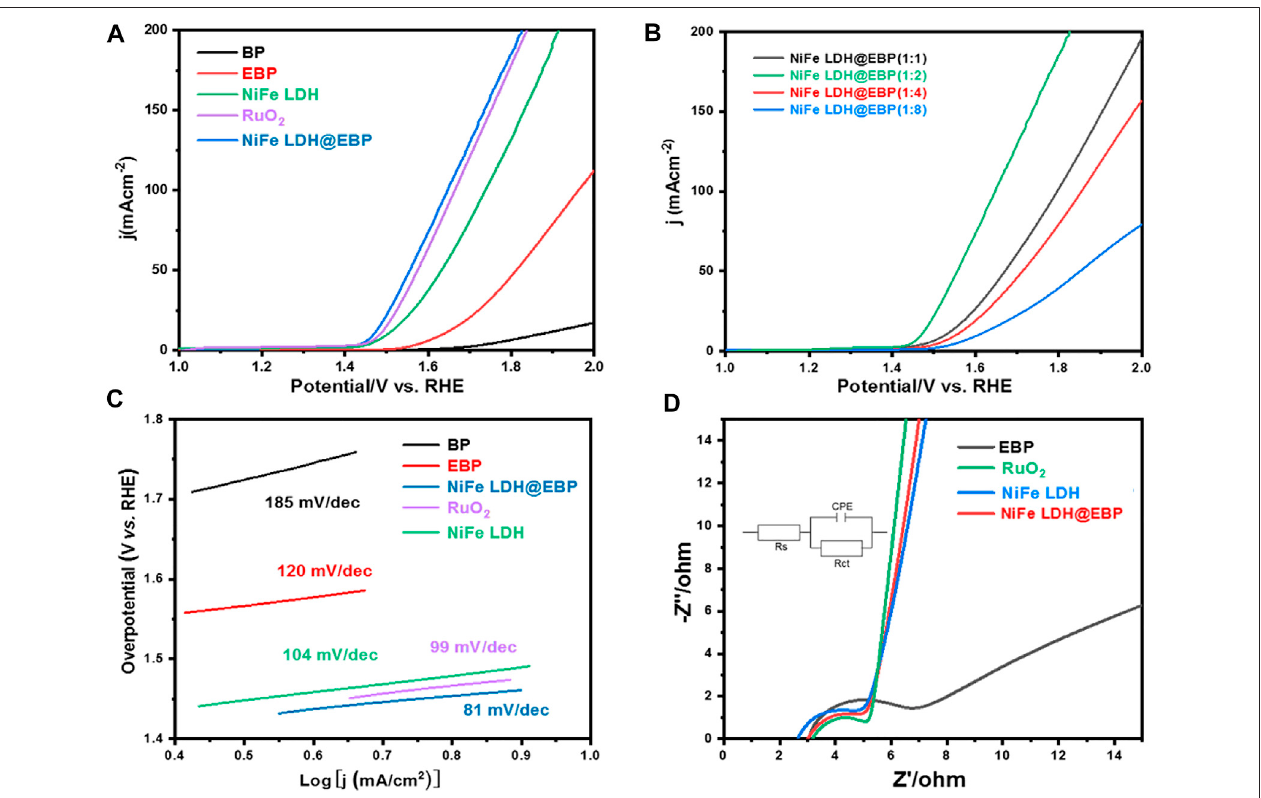
FIGURE 5 |(A) LSV curves for BP, EBP, NiFe-LDH and NiFe LDH@EBP, and RuO 2 , (B) LSV curves of NiFe LDH@EBP sampleswith different feed weight ratios of NiFe-LDH to EBP, (C) Tafel plots for BP, EBP, NiFe-LDH and NiFe LDH@EBP, and commercial RuO 2 , and (D) EIS curves for EBP, NiFe-LDH and NiFe LDH@EBP, and commercial RuO 2